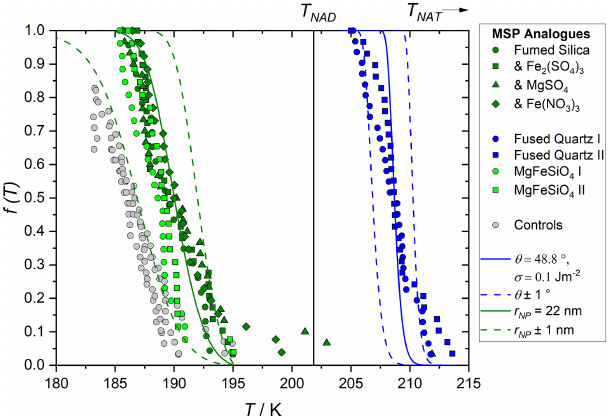
Figure 9. Meteoric smoke particle (MSP) analogue fraction frozen as measured in our previous work (points, James et al. 2018) and as modelled here using the size-dependent nucleation rate parame- terisation described by Eqs. (1)–(4), lines. Grey points show the in- strument background. Blue data show nucleation measured on fused quartz (BET surface area 4.85m 2 g − 1 ) and green data fumed silica (BET surface area 195m 2 g − 1 ). Fused quartz data are used to con- strain the contact angle for a given surface energy since this is insen- sitive to particle size, solid blue line shows 0.1Jm − 2 as an exam- ple, and dashed blue lines show the sensitivity to the contact angle. These paired θ and σ values are then used to determine the nucle- ating particle radius, r NP , which gives a good fit (solid green line) to the fumed silica data, again shown here for σ NAT = 0 . 1Jm − 2 , dashed green lines show the sensitivity to the particle